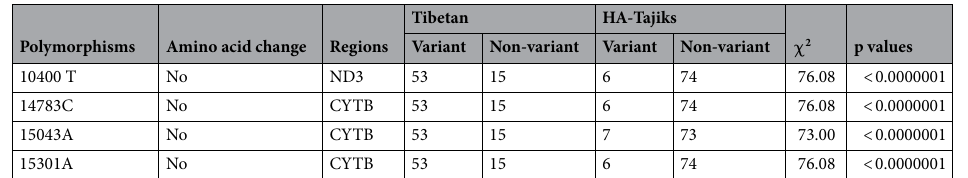
Table 2. Results with p values below 0.0000001 in the comparison of the mtDNA genome between Tibetans and HA-Tajiks.